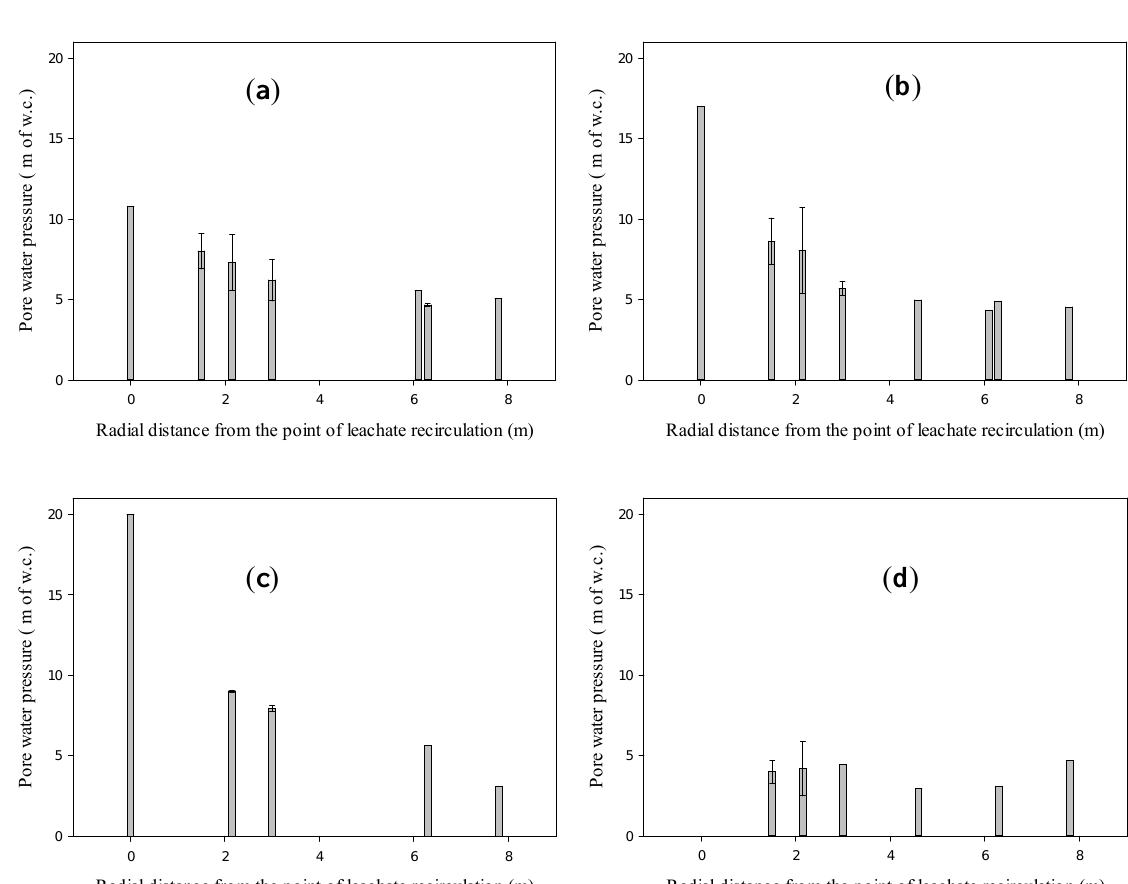
Figure 7. Pore pressure variation in the waste surrounding Well 2 as a function of radial distance on day 93, while the leachate was actively added to the well. Error bars indicate one standard deviation of uncertainty. ( a ) At a depth of 5.8 m from the surface of the landfill; ( b ) At a depth of 11.9 m from the surface of the landfill; ( c ) At a depth of 14.9 m from the surface of the landfill; ( d ) At a depth of 18 m from the surface of the